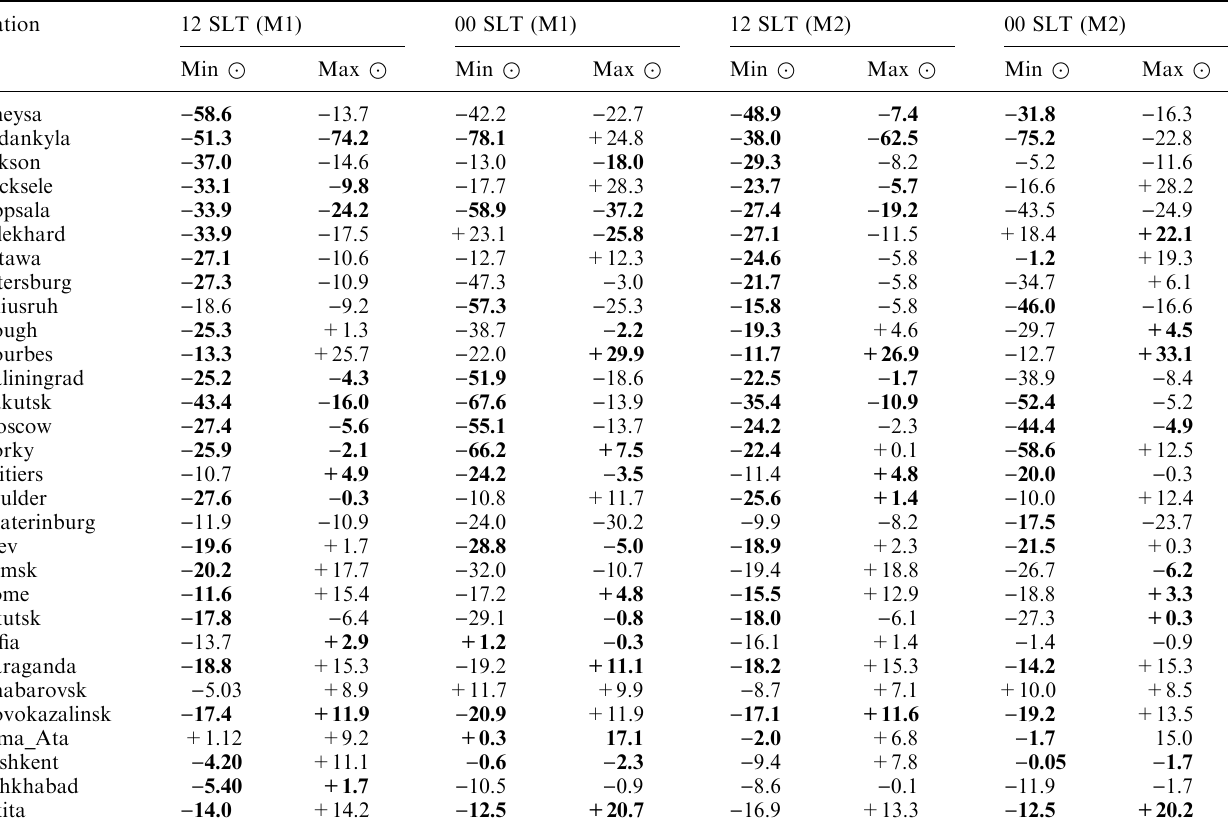
Table 3. Calculated annual mean slope K (in 10 ) 4 per year) for the period after 1965. Regressions of f oF2 with R R + Ap (model 2) are used to produce f oF2 trends for years of 12